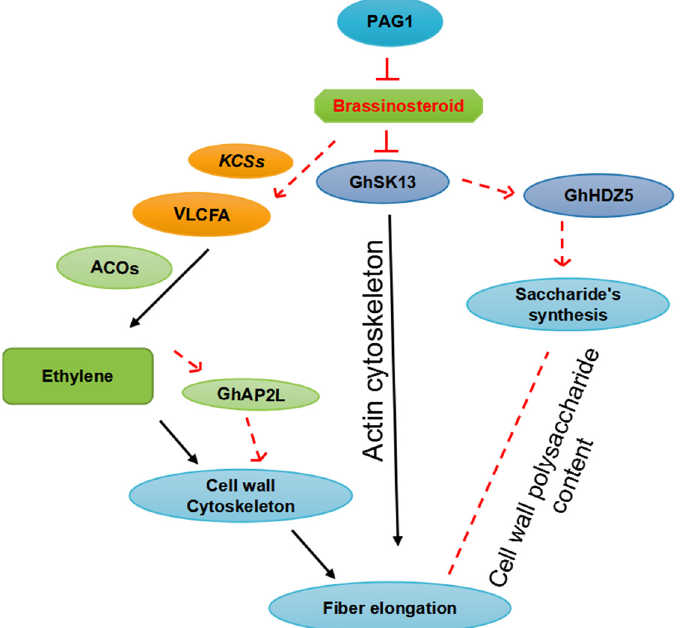
Figure 2. Model representation of how PAG1 and BR regulate fiber elongation. PAG1 catabolism activates endogenous BRs, which stimulate the expression of enzymes involved in very-long-chain fatty acid (VLCFA) biosynthesis, such as KCSs. VLCFAs promote fiber elongation by activating the expression of ETH biosynthesis genes (ACOs). Both ETH and BRs promote fiber elongation by stimulating the expression of cell wall and cytoskeleton-related genes. BRs also affect fiber elongation and BR-GhSK13 fiber development in cotton.